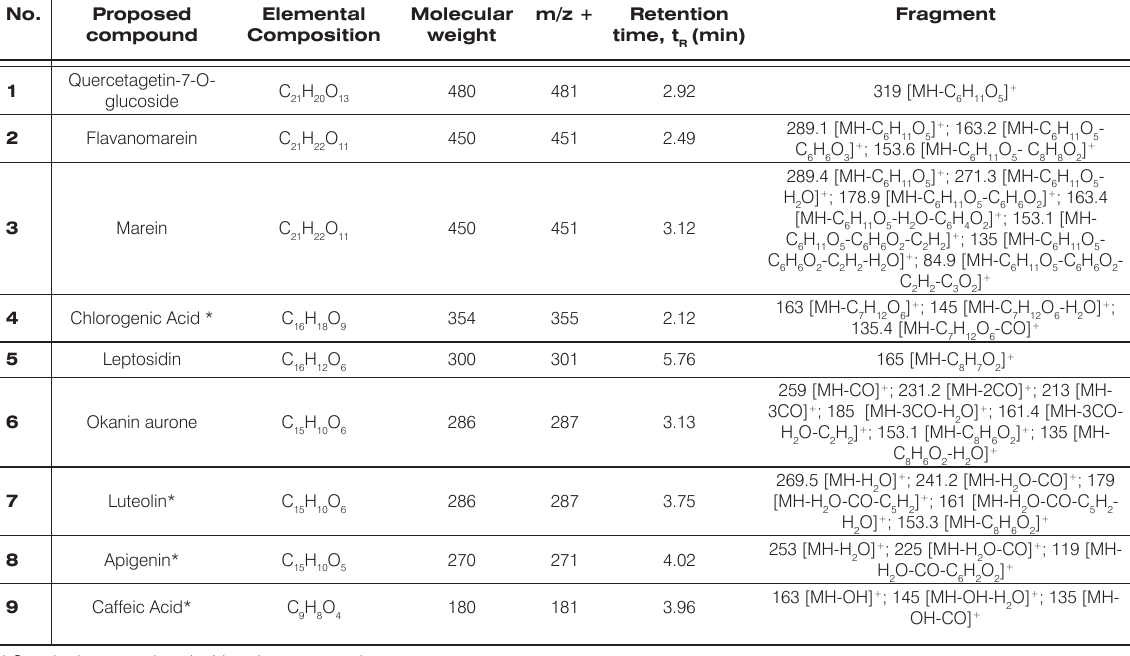
Table 1. The results of qualitative LC-MS/MS analysis (ESI, positive ion) of the extract from dried fruits of Coreopsis tinctoria Nutt. by sonication with ethanol (30°C, 60 min, liquid-solid ratio 10/1). No. Proposed Elemental compound